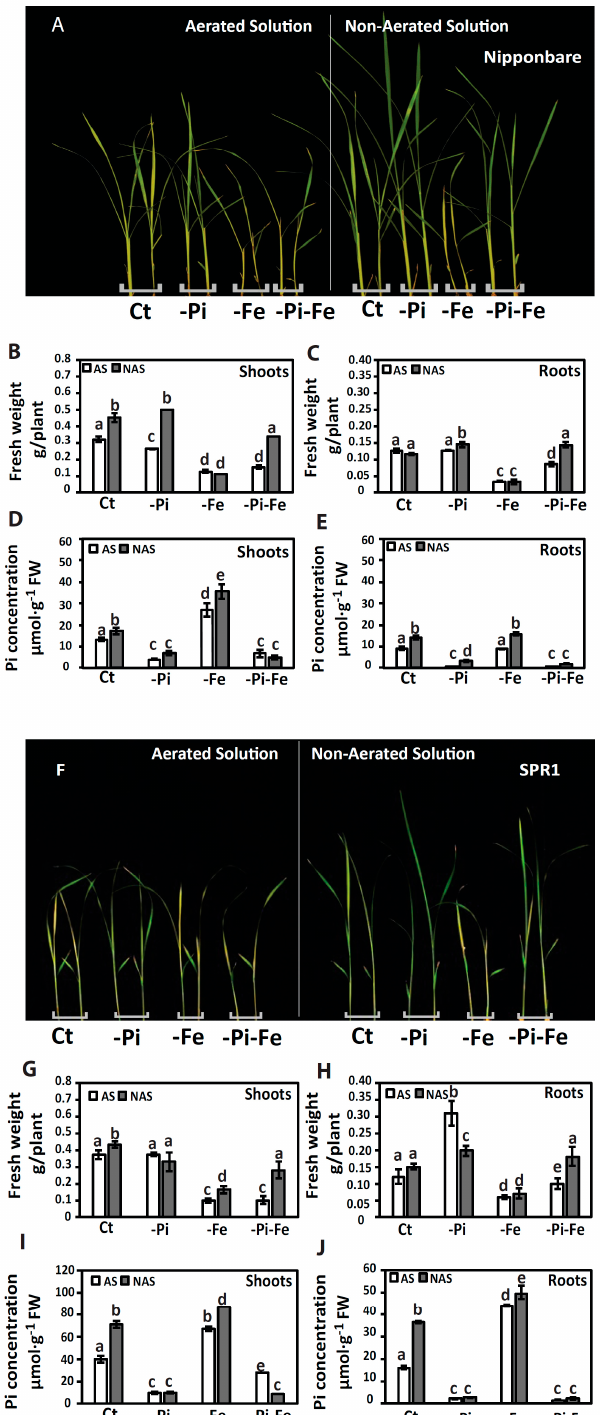
Figure 1. Responses of lowland rice (Nipponbare, Suphanburi 1 (SRP1) varieties) seedlings grown under various O 2 and nutrient deficiency conditions. Ten-day-old seedlings were transferred to one of the combinatory treatments consisting of O 2 (aerated solution (AS) and non-aerated solution (NAS)) nutrient treatments (full strength nutrient solution (Ct), phosphate deficiency ( − Pi), iron deficiency ( − Fe) and Pi and Fe deficiency ( − Pi-Fe)). ( A , F ) phenotypes of seedlings after 10 days of treatment; ( B , G ) shoots and ( C , H ) roots biomass of seedlings after 10 days of treatment; ( D , I ) shoots and ( E , J ) roots Pi concentration of seedlings after 10 days of treatment. The data are given as mean ± s.e. ( n = 3). Letters a, b, c, d, e on histograms indicate statistical significance at p < 0.05. FW, fresh weight.